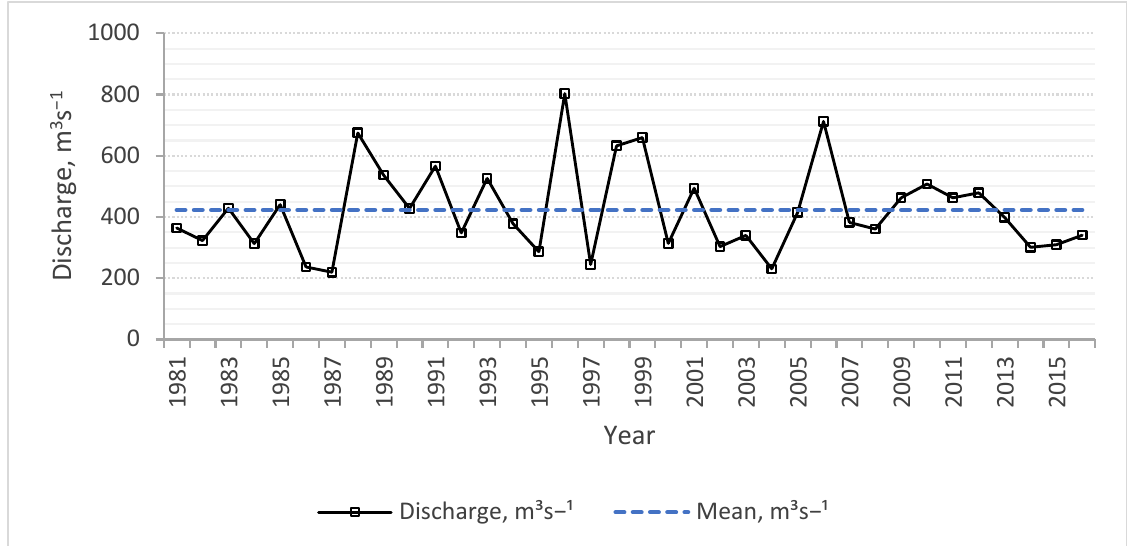
Figure 2. Annual maximum flow records of Awash-Hombole River.